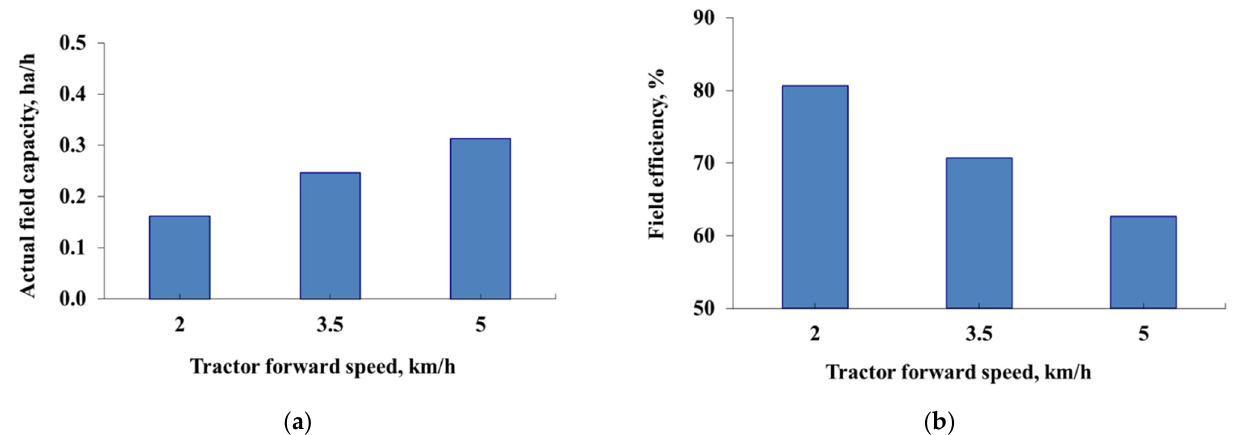
Figure 4. The effect of the tractor forward speed on ( a ) Actual field capacity and ( b ) field efficiency.